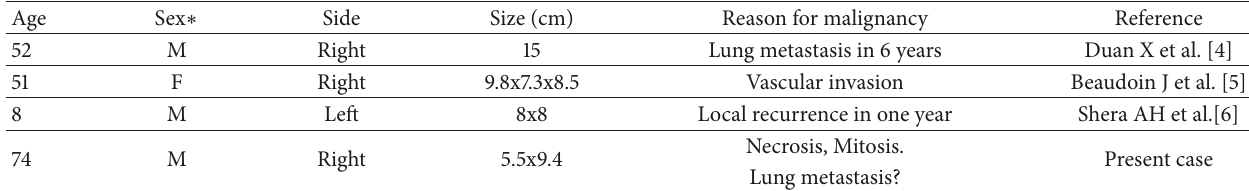
Table 2: Reported potentially malignant juxtaglomerular cell